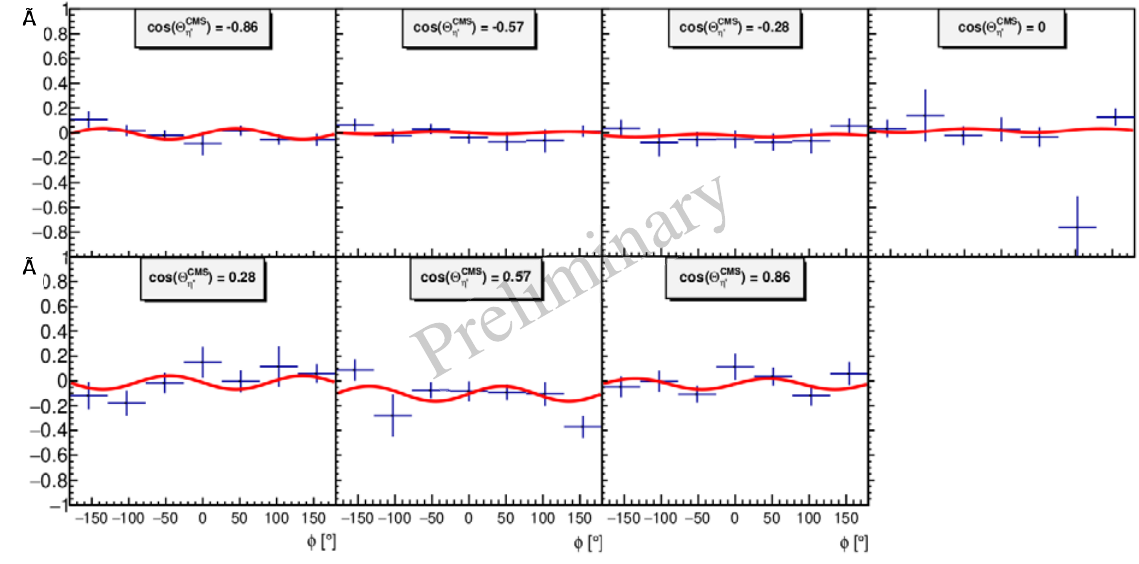
(cid:4) (cid:5) Θ CMS bins. Only statistical errors shown. η (cid:2)